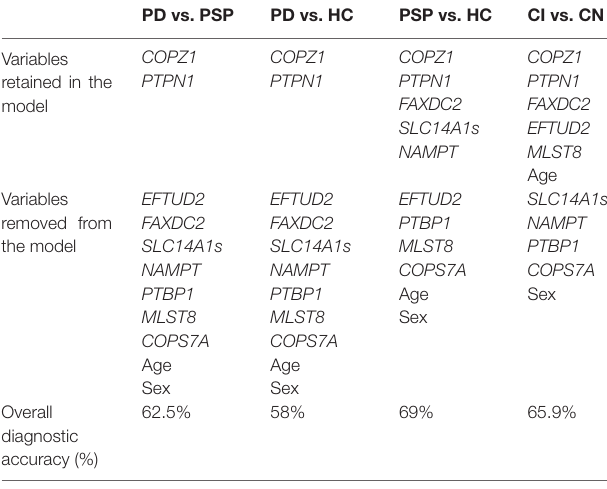
TABLE 3 | Linear discriminant analysis for RNA PD biomarkers tested in PDBP. PD vs.